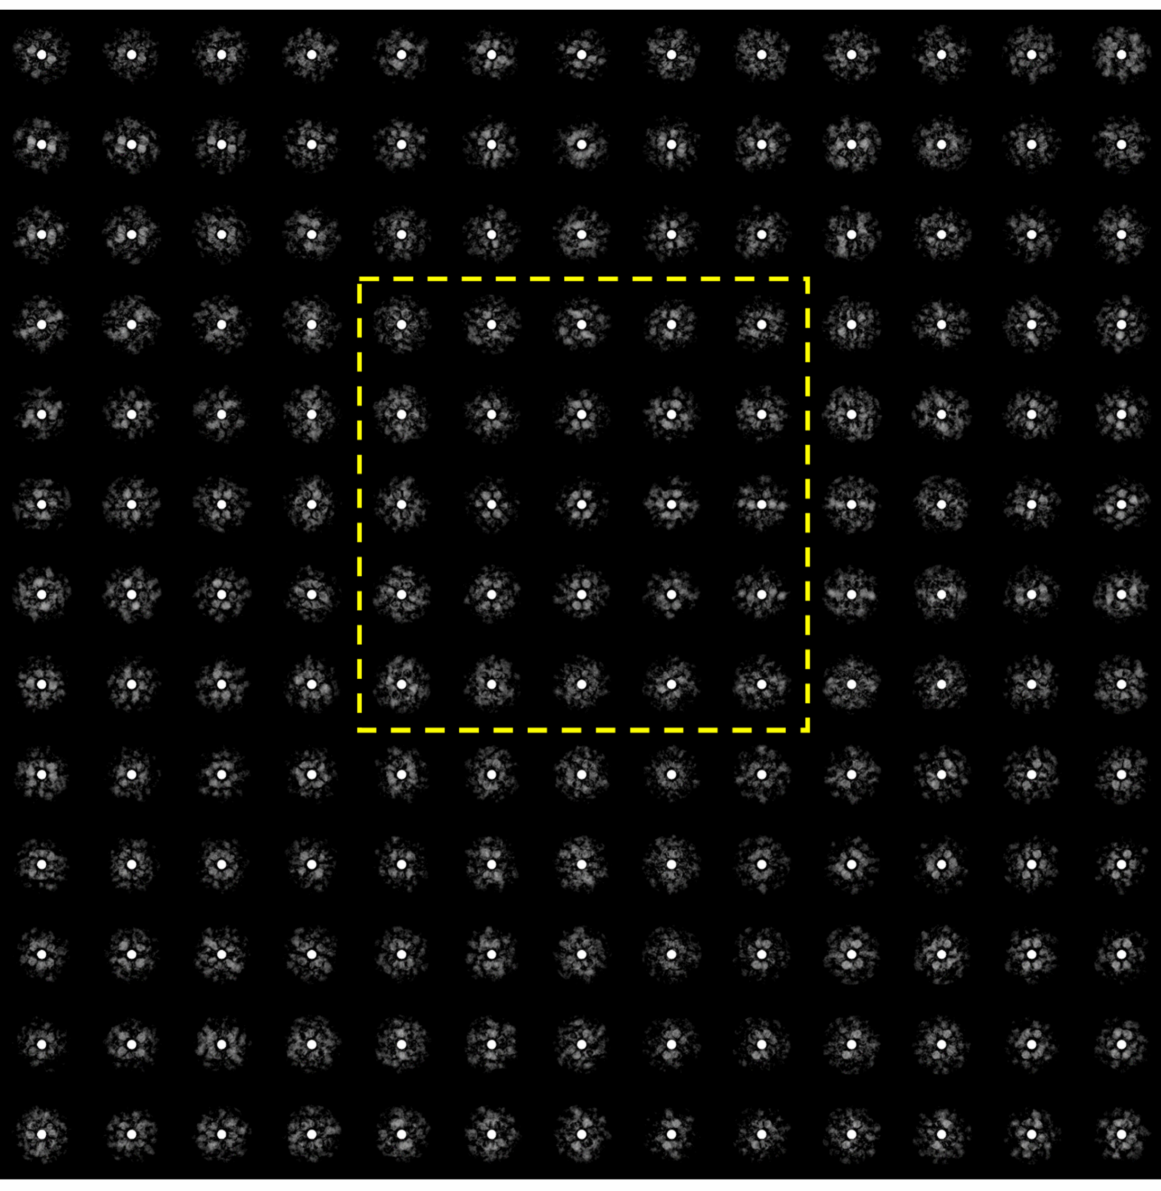
polyhedron consisting of 12 atoms has a Voronoi index of <0 2 8 1 0 0>, which is a dominant index in a Zr 80 Pt 20 metallic glass